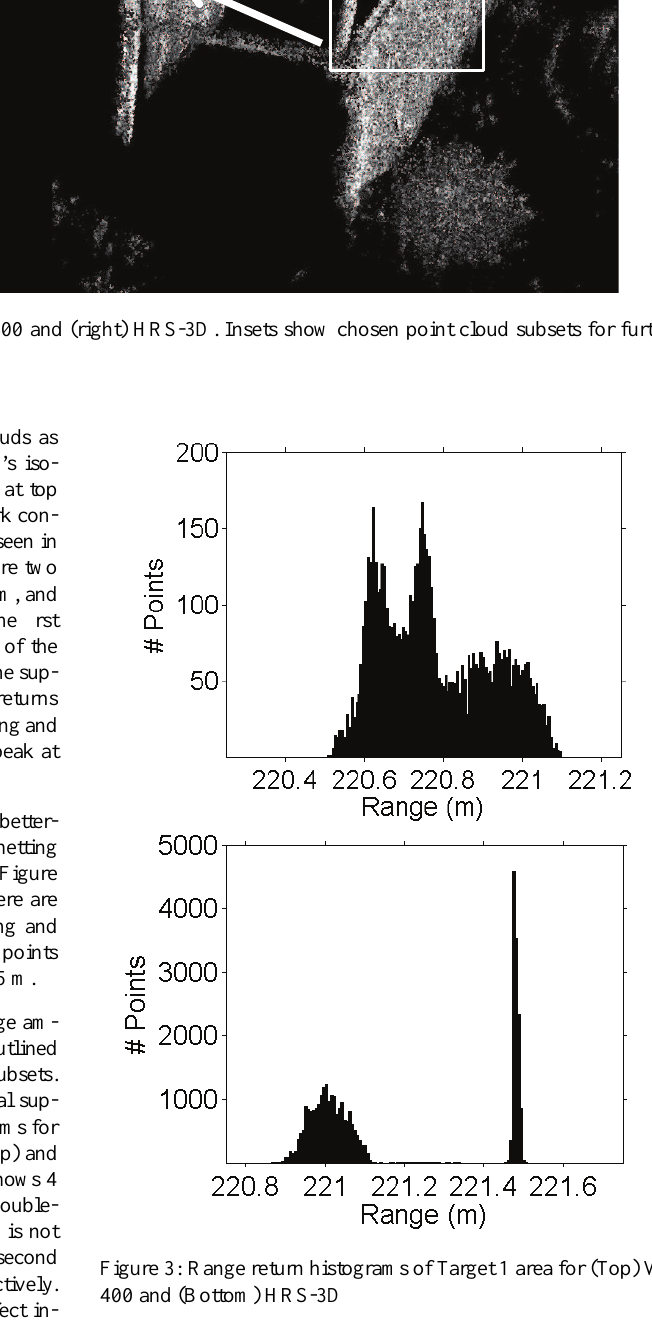
lower portion of the vertical support approximately 15 cm closer. The backboard return is located at approximately 185.7 m. There is also a considerable ”filling-in” of returns between the mesh and vertical support in the VZ-400 data as can be seen between 184.5 and 185